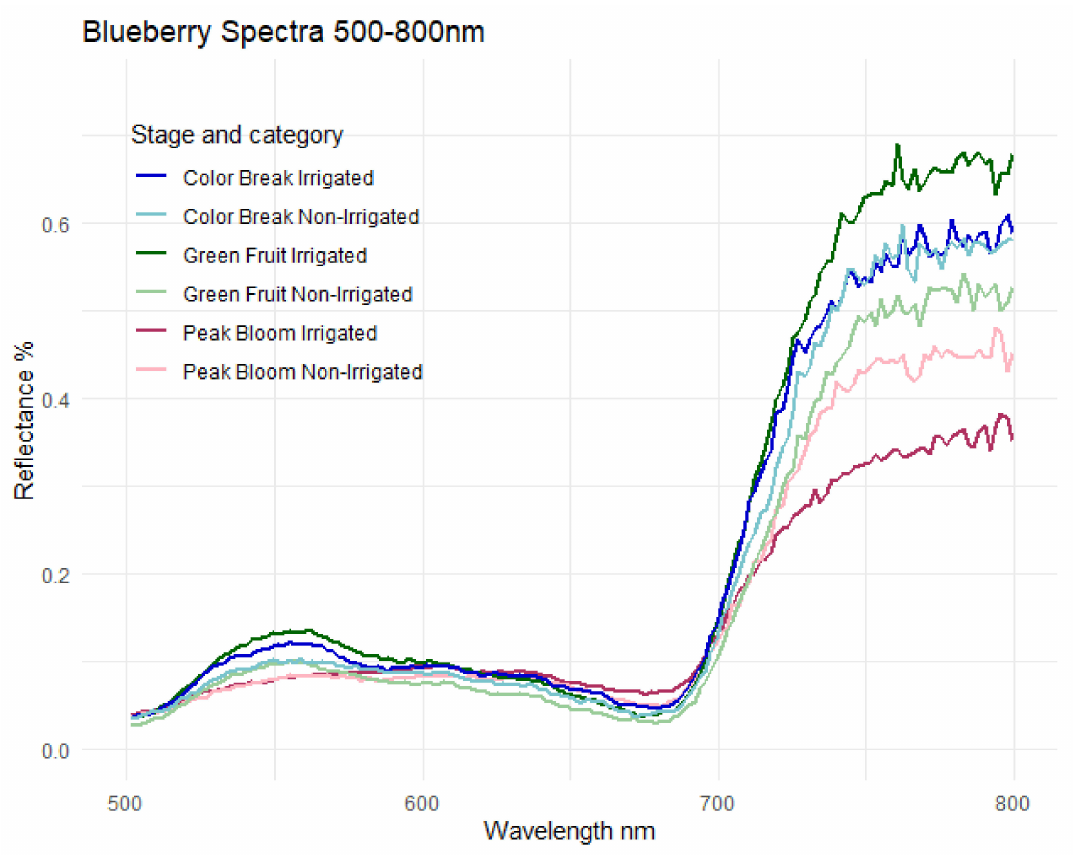
Figure 4. Spectral plots of median reflectance for all sampled blueberry pixels from each field and